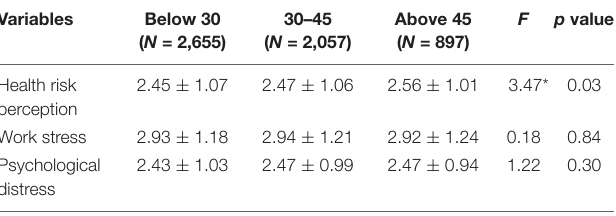
TABLE 4 | One-way ANOVA of health risk perception, work stress, and psychological distress among different age groups of police officers.